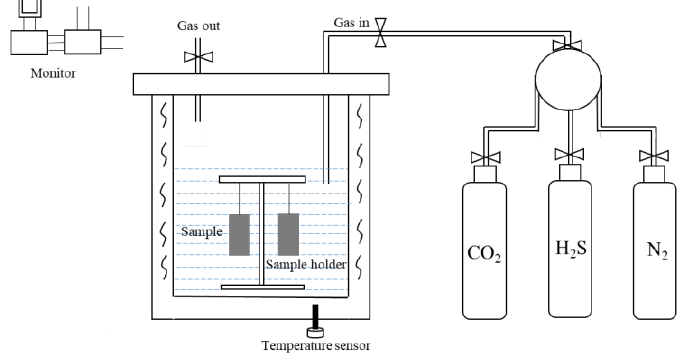
Figure 3. Schematic diagram of self-designed C276 alloy HTHP